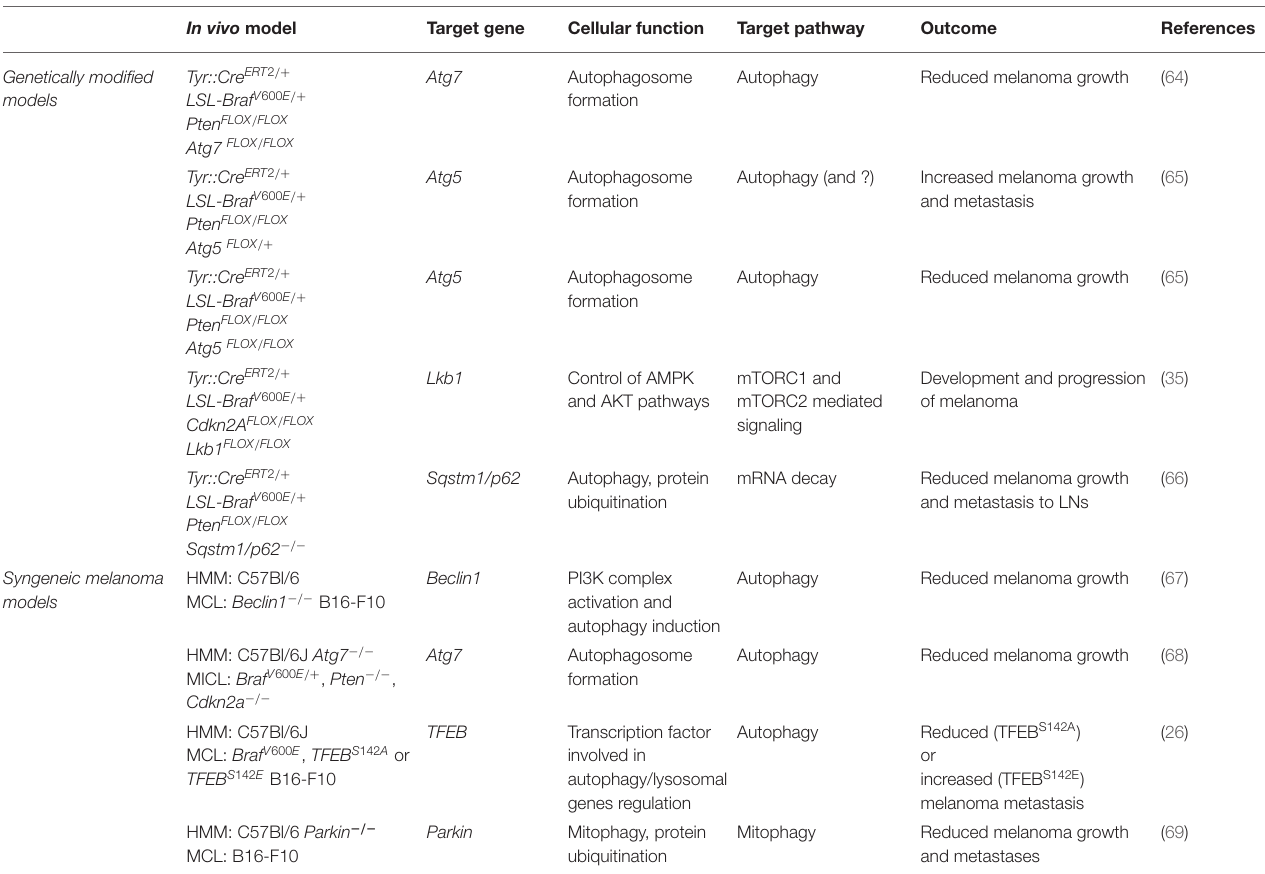
TABLE 1 | Melanoma mouse